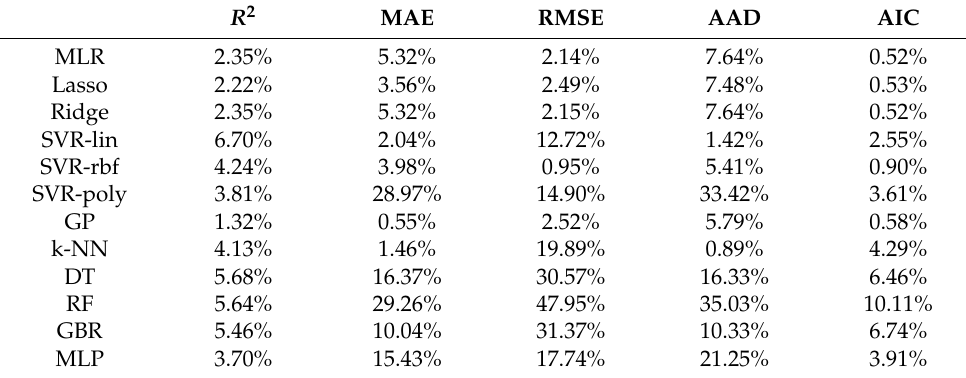
Table 8. Measures of accuracy comparison. Values for each measure correspond to the percentage of loss when the all-input case is substituted by the six PCA inputs case. R 2 MAE RMSE AAD AIC MLR 2.35% 5.32% 2.14% 7.64% 0.52% Lasso 2.22% 3.56% 2.49% 7.48% 0.53% Ridge 2.35% 5.32% 2.15% 7.64% 0.52% SVR-lin 6.70% 2.04% 12.72% 1.42% 2.55% SVR-rbf 4.24% 3.98% 0.95% 5.41% 0.90% SVR-poly 3.81% 28.97% 14.90% 33.42% 3.61% GP 1.32% 0.55% 2.52% 5.79% 0.58% k-NN 4.13% 1.46% 19.89% 0.89% 4.29% DT 5.68% 16.37% 30.57% 16.33% 6.46% RF 5.64% 29.26% 47.95% 35.03% 10.11% GBR 5.46% 10.04% 31.37% 10.33% 6.74% MLP 3.70% 15.43% 17.74% 21.25%